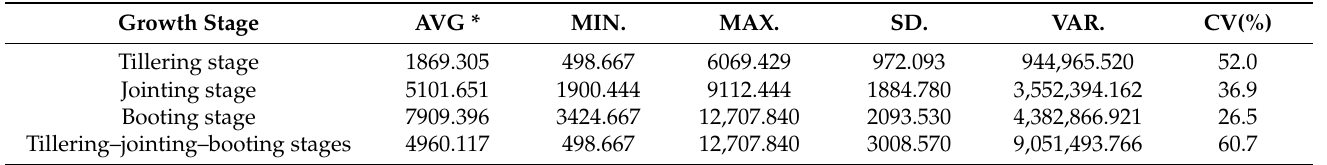
Table 3. Statistical analysis of AGB values at different growth stages.